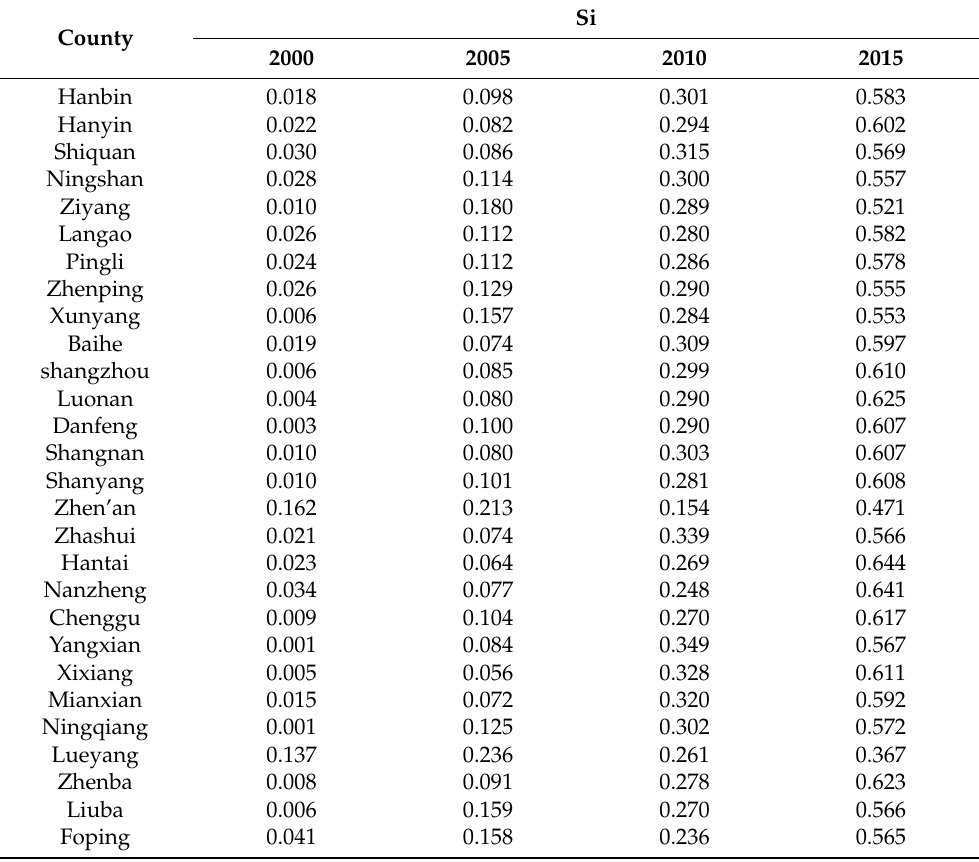
Table 9. Scores of socioeconomic development levels of counties in the Qinba